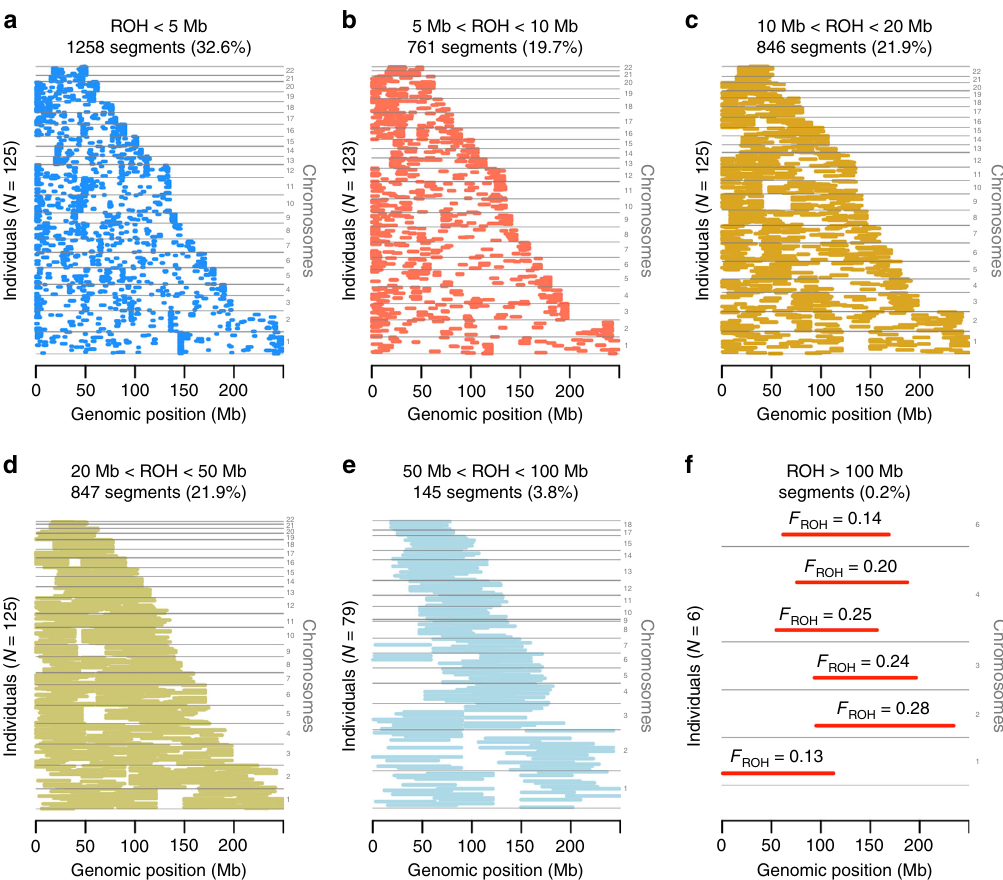
Fig. 3 Chromosomal and positional distribution of runs of homozygosity (ROHs) detected in 125 EI cases ( F ROH > 0.1). Each row, with possibly multiple segments, represents a unique participant. Segments are groups by autosomal chromosomes from chromosome 1 (bottom of each panel) to chromosome 22 (top of each panel) ROHs are grouped in 6 length categories: between 1.5 and 5 Mb ( a ), between 5 and 10 Mb ( b ), between 10 and 20 Mb ( c ), between 20 and 50 Mb ( d ), between 50 and 100 Mb ( e ), and above 100 Mb ( f ). f also show inbreeding coef fi cients of individuals harbouring the largest ROHs